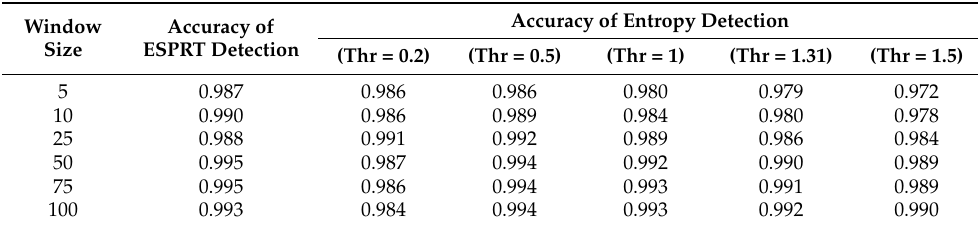
Table 1. Accuracy of ESPRT and entropy for different window sizes and thresholds. Window Size